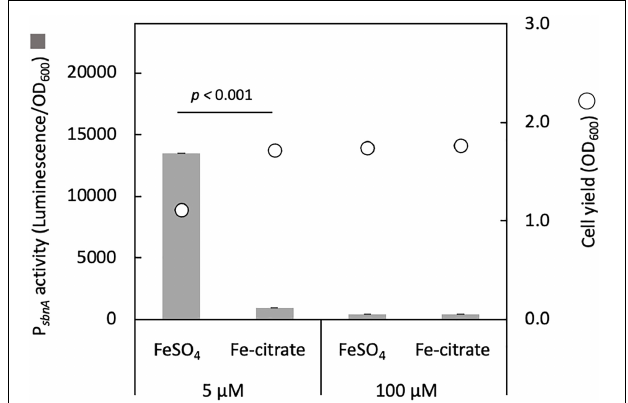
FIGURE 2 | sbnA promoter activity assay with luciferase as a reporter in the wild type grown on succinate in the presence of 5 and 100 µ M FeSO 4 or iron citrate. Bars, sbnA promoter activity (arbitrary unit, luminescence/OD 600 ); circles, cell yield (OD 600 ). The results were presented as the average ± standard deviation (SD) (biological